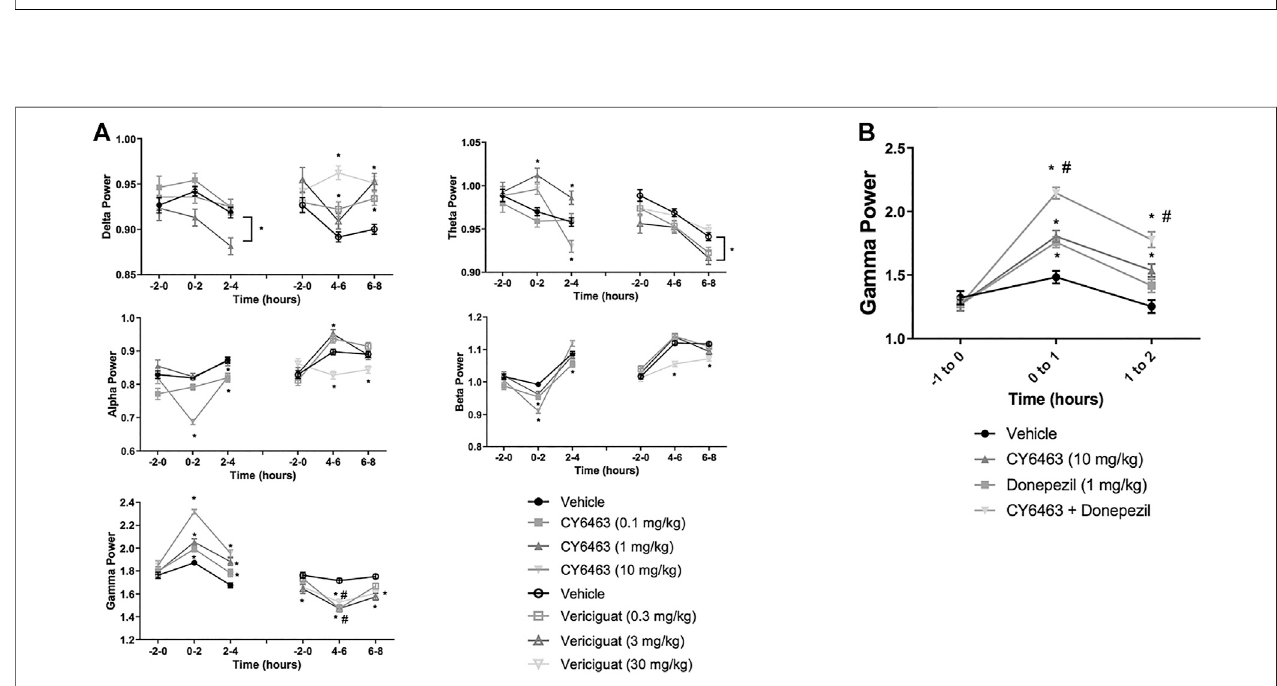
FIGURE4| EffectsofcompoundadministrationoncorticalqEEGinawakeduringtheA.M.period. (A) ,CY6463andvericiguat,annotatedDunnett ’ sposthoctests * p < 0.05 compared to vehicle-treated rats, # p < 0.05 compared to baseline. (B) , CY6463 and donepezil. Annotated Tukey ’ s post hoc tests: * p < 0.05 compared to vehicle-treated rats, # p < 0.05 compared to CY6463. All data are expressed as mean ± SEM.